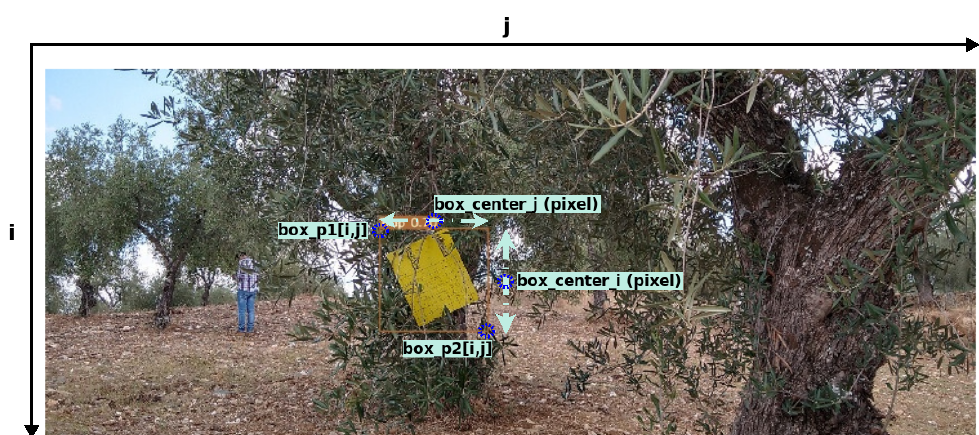
Figure 5. YOLO providing the object detection. Note that the code extracts the objected center and its extremities, given the object occupancy in the image.